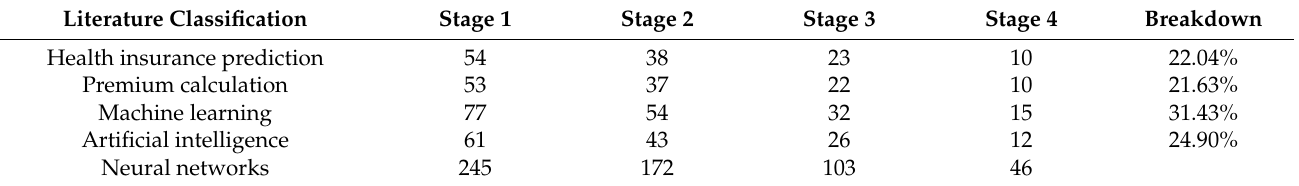
Table 1. Research literature classification.